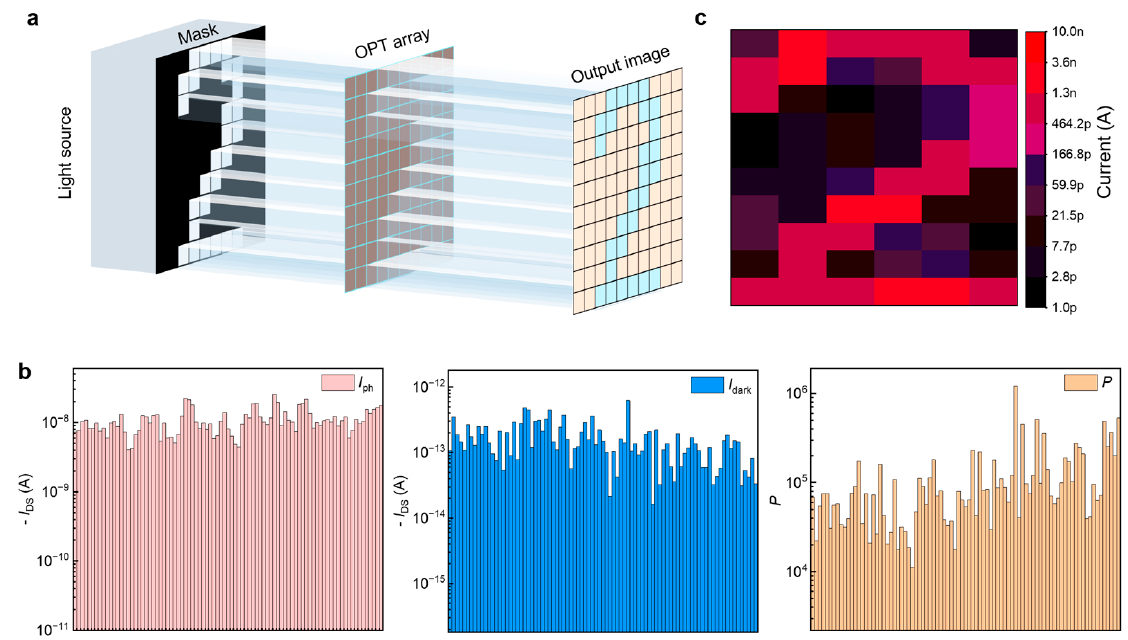
Figure 4. Imaging function demonstration. ( a ) Schematic diagram illustrating the device arrangement of the OPT array for imaging function. ( b ) Distribution of the dark, photocurrent, and photosensitivity of the fully printed device array. ( c ) Reconstructed image of “2” by the OPT array.